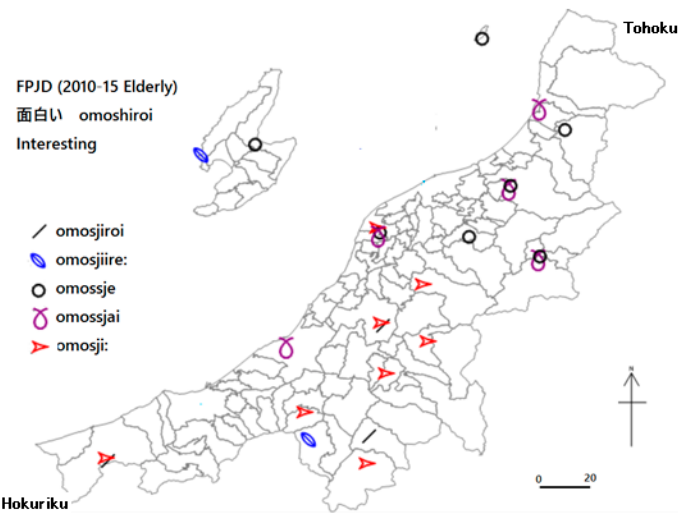
Figure 8. Lexical variation of omoshiroi “interesting” in Niigata: FPJD data.